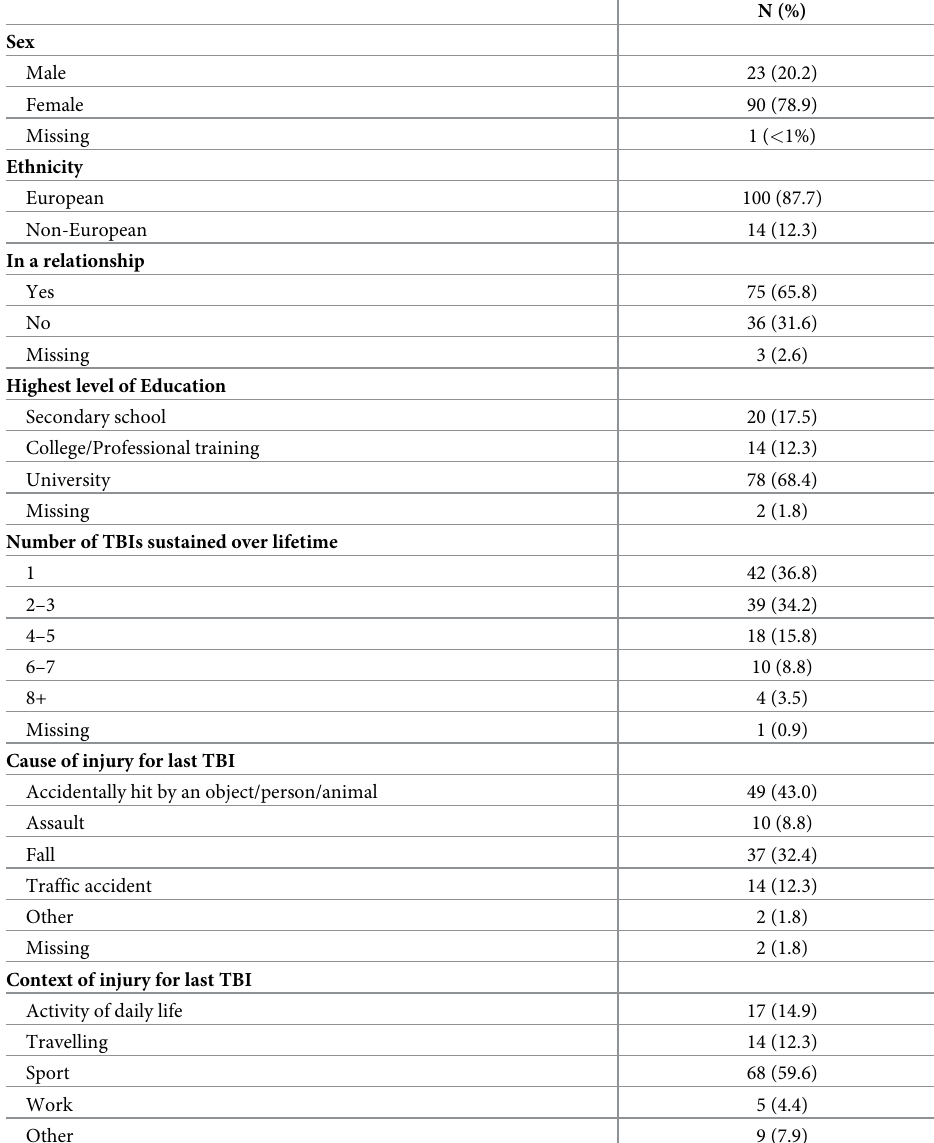
Table 2. Participant characteristics for the sample of N =